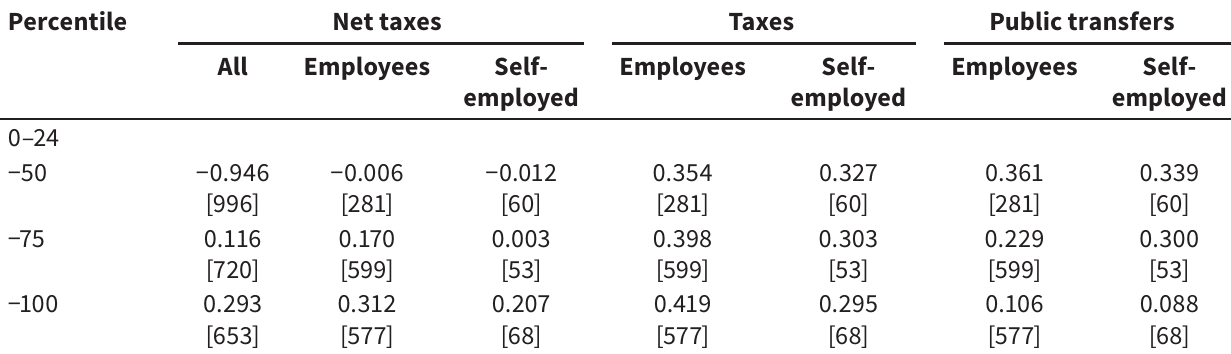
Household statutory average net tax rates in Lithuania, net taxes as a share of gross employment income.